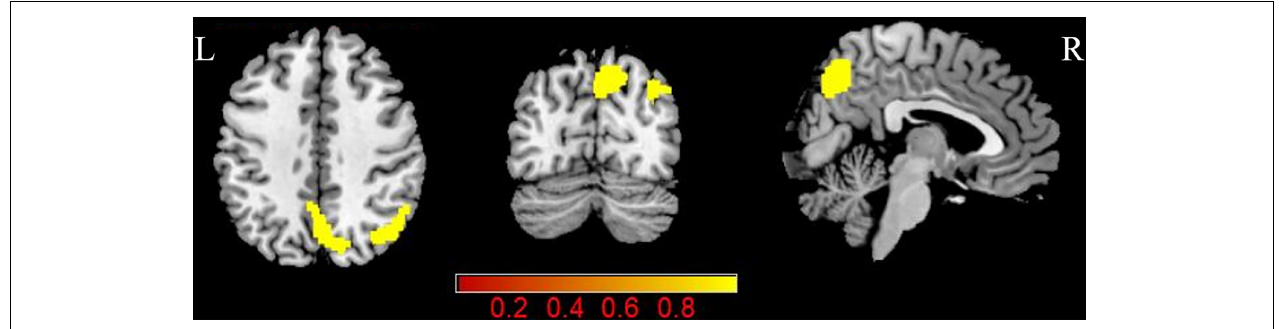
FIGURE 2 | Group differences in CBF between patients with PT and NCs ( P < 0.05, FDR corrected). PT: pulsatile tinnitus; NC: normal control; CBF: cerebral blood flow; ReHo: regional homogeneity.